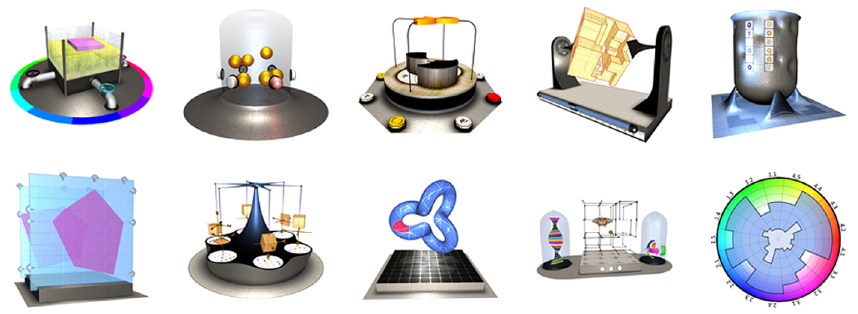
Figure 7. Gallery of developed